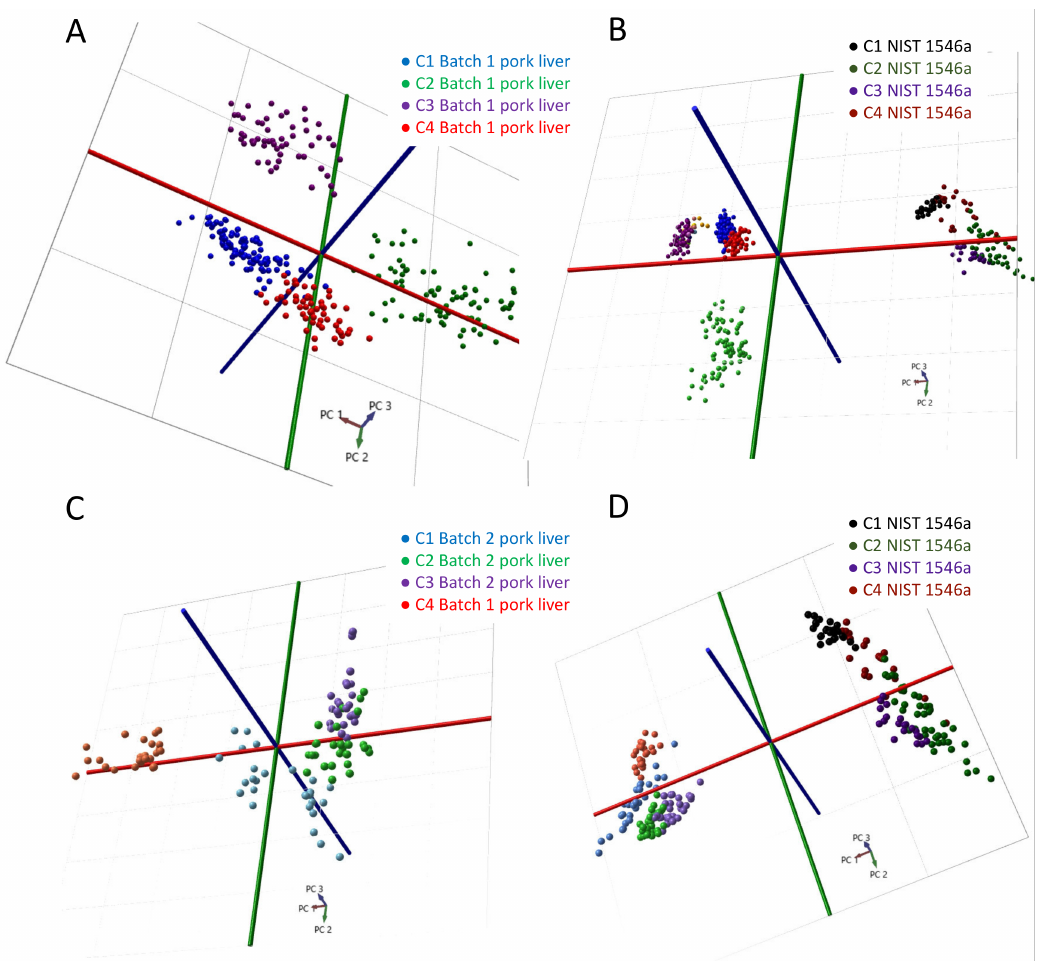
Figure 3. Multivariate analysis of REIMS spectra from reference pork liver and NIST meat ho- mogenate determined at each center. PCA was used to study variability in multiple REIMS spectra acquired from a single source of pork liver before (variance explained by PC1, PC2 and PC3 are respectively 59.62%, 18.14% and 9.86%) ( A ) and after method harmonization (variance explained by PC1, PC2 and PC3 are respectively 63.83%, 10.85% and 8.03%) ( C ). PCA was also used to study differences in spectra among centers and two types of reference material (pork liver and NIST meat homogenate) prior to (variance explained by PC1, PC2 and PC3 are respectively 71.87%, 14.56% and 4.05%) ( B ) and after method harmonization (variance explained by PC1, PC2 and PC3 are respectively 34.1%, 21.03% and 12.49%) ( D